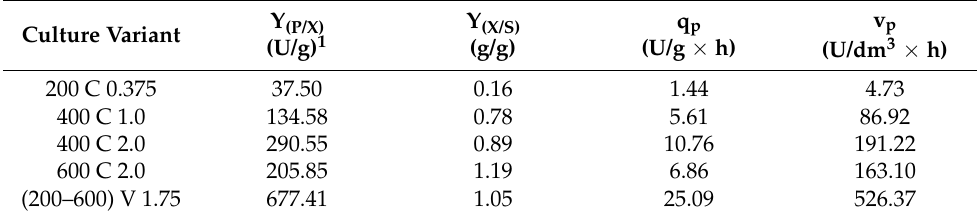
Table 3. Selected culture parameters of Y. lipolytica in a medium with waste fish oil. Culture